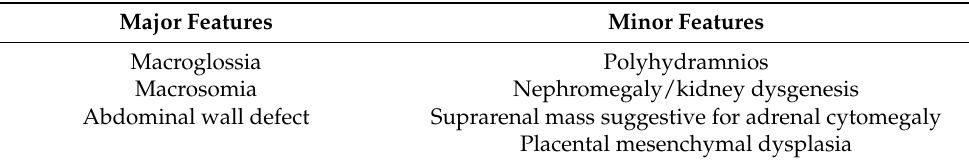
Table 1. Prenatal clinical features associated with